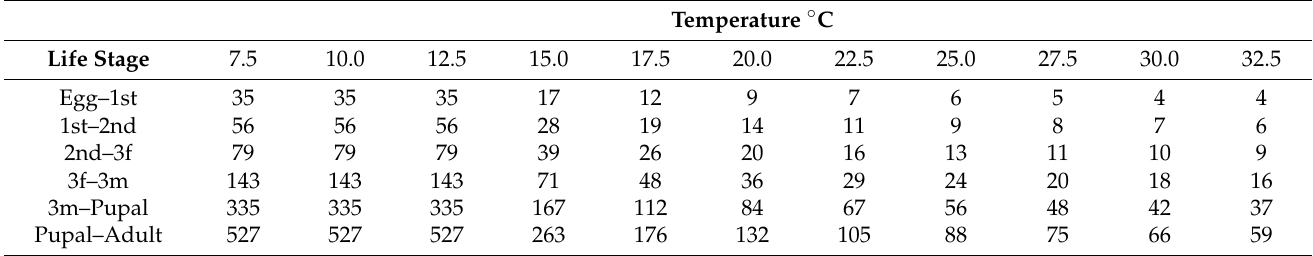
Table 1. Sample times for Lucilia sericata were calculated by converting the minimum and maximum data reported in Kamal [4] into accumulated degree hours (ADH). The ADHs were calculated for each life stage and sampling temperature, converted back into hours and divided into 5 equal sample times.